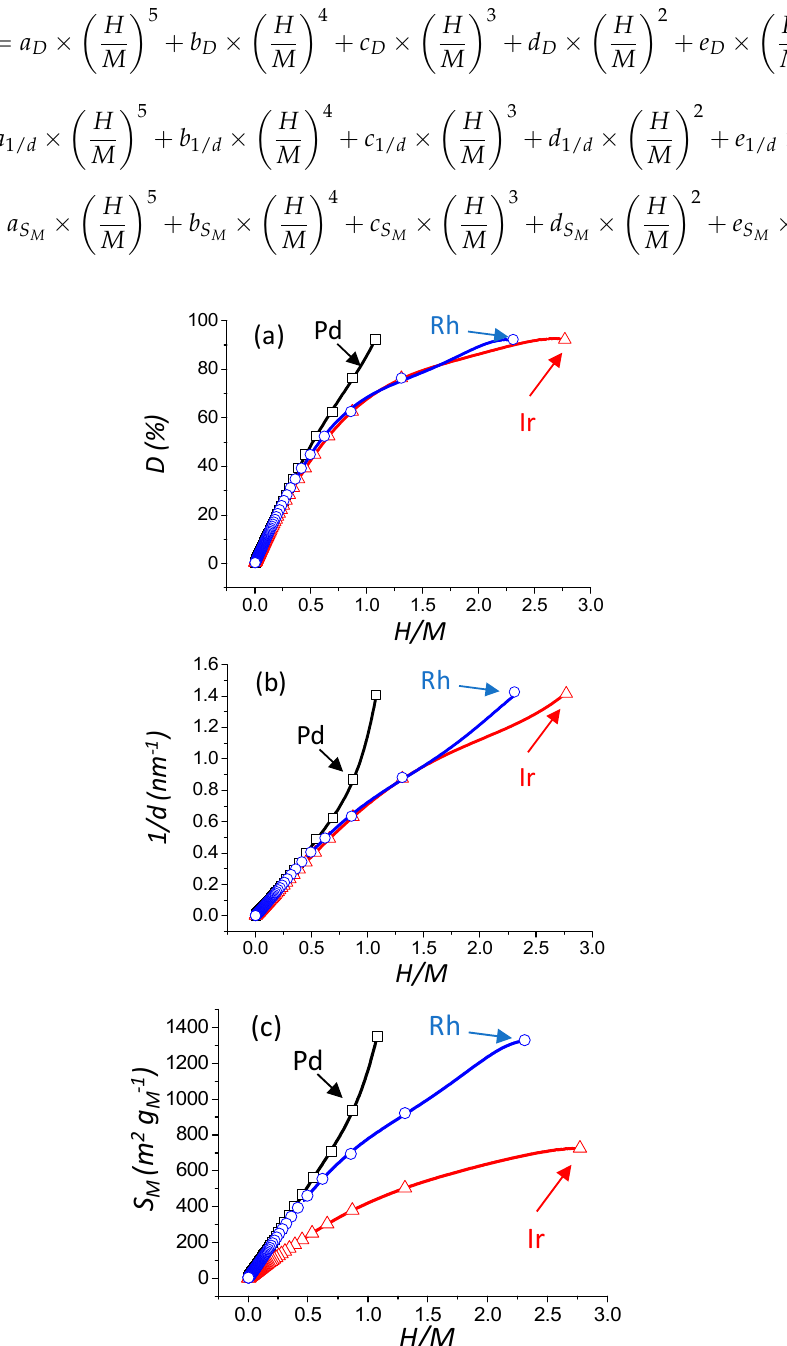
Figure 3. Evolution of the theoretical dispersion versus H/M theoretical ratio ( M = Pd, Ir, or Rh) ( a ). Evolution of the theoretical reciprocal particle size versus H/M theoretical ratio ( b ). Evolution of the theoretical metallic specific surface area versus H/M theoretical ratio ( c ). Open square, triangle, and circle: result of the statistical model calculation of this work for Pd, Ir, and Rh, respectively. The black, blue, and red curves are the fitting result ( R 2 = 1.000) with a 5th order polynomial trend line (see Equations (8)–(10)) for Pd, Rh, and Ir, respectively.